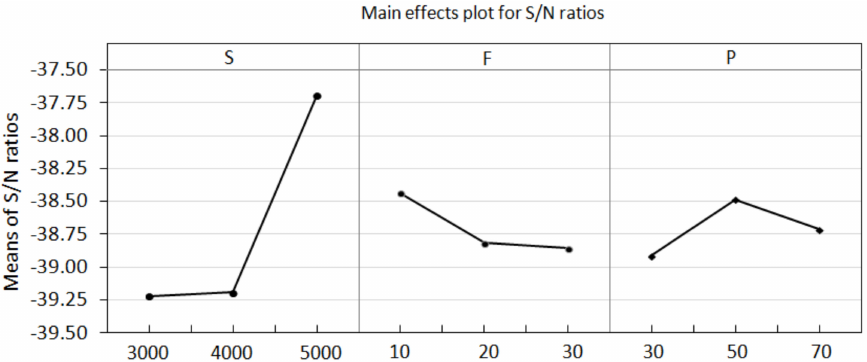
Figure 6. Main effects plot for cutting force.